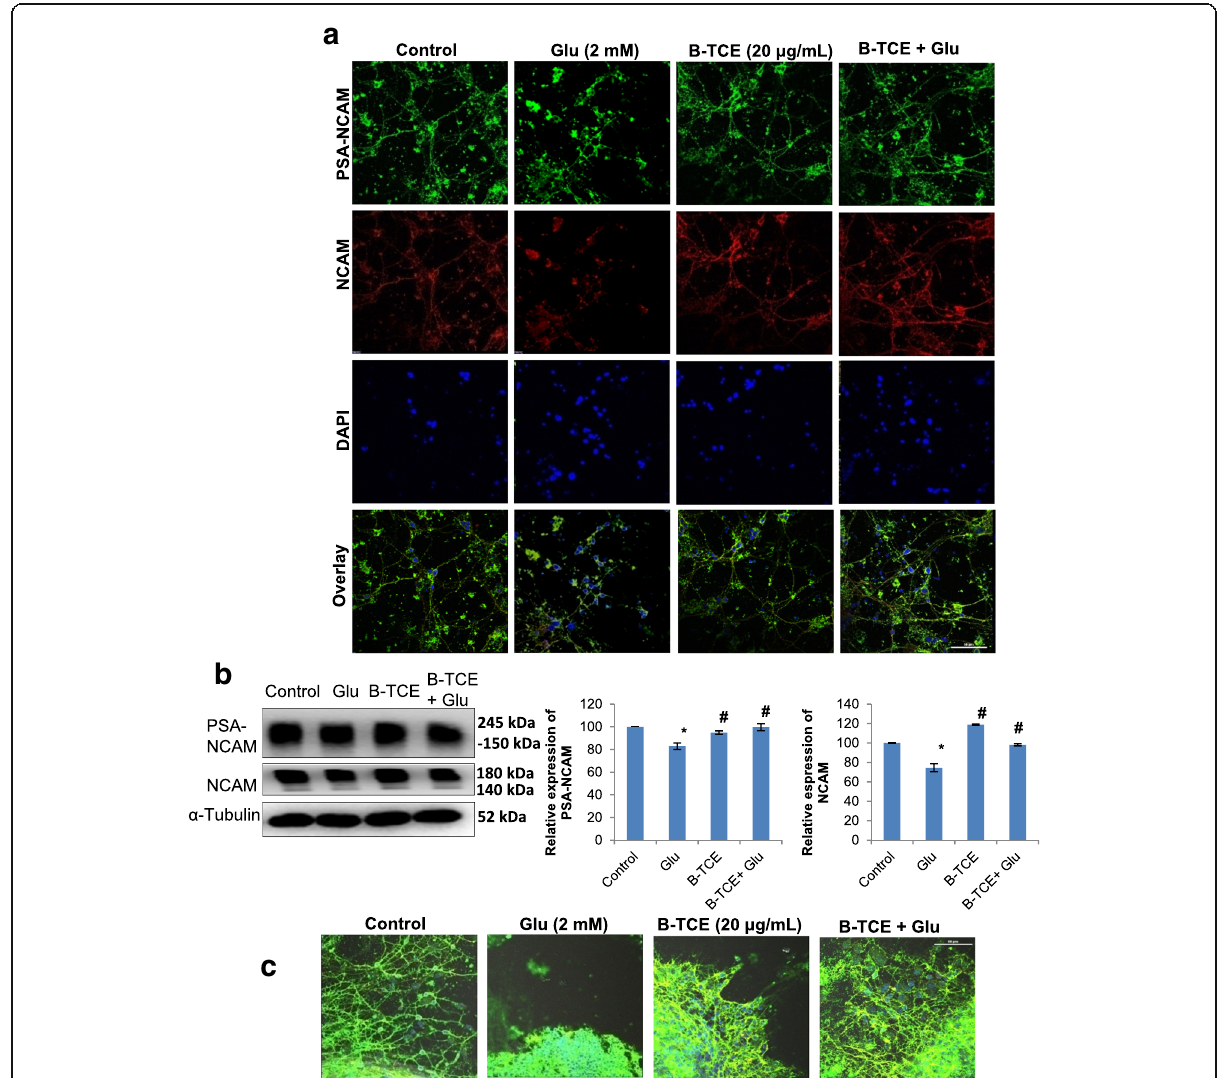
Fig. 5 B-TCE pretreatment promoted plasticity, neurite outgrowth and migration and protected from glutamate-induced excitotoxicity. a ) Confocal micrographs of Control, Glutamate (2 mM), B-TCE (20 μ g/mL) and B-TCE + Glu treated primary cerebellar neurons immunostained for PSA-NCAM and NCAM. Nuclei were stained with DAPI (third panel). The fourth panel represents the overlay of above three panels. b ) Representative immunoblots and histograms representing relative expression PSA-NCAM and NCAM where α -Tubulin was used as internal control. c ) Overlay confocal micrographs of primary cerebellar explants stained for PSA-NCAM, NCAM and DAPI. Data was compared between Control and other groups such as Glutamate, B-TCE and B-TCE + Glu ( * p ≤ 0.01) as well as Glutamate alone with B-TCE and B-TCE + Glu groups ( # p ≤ 0.01). Confocal Images were captured at 60X objective (Scale bar: 50 μ